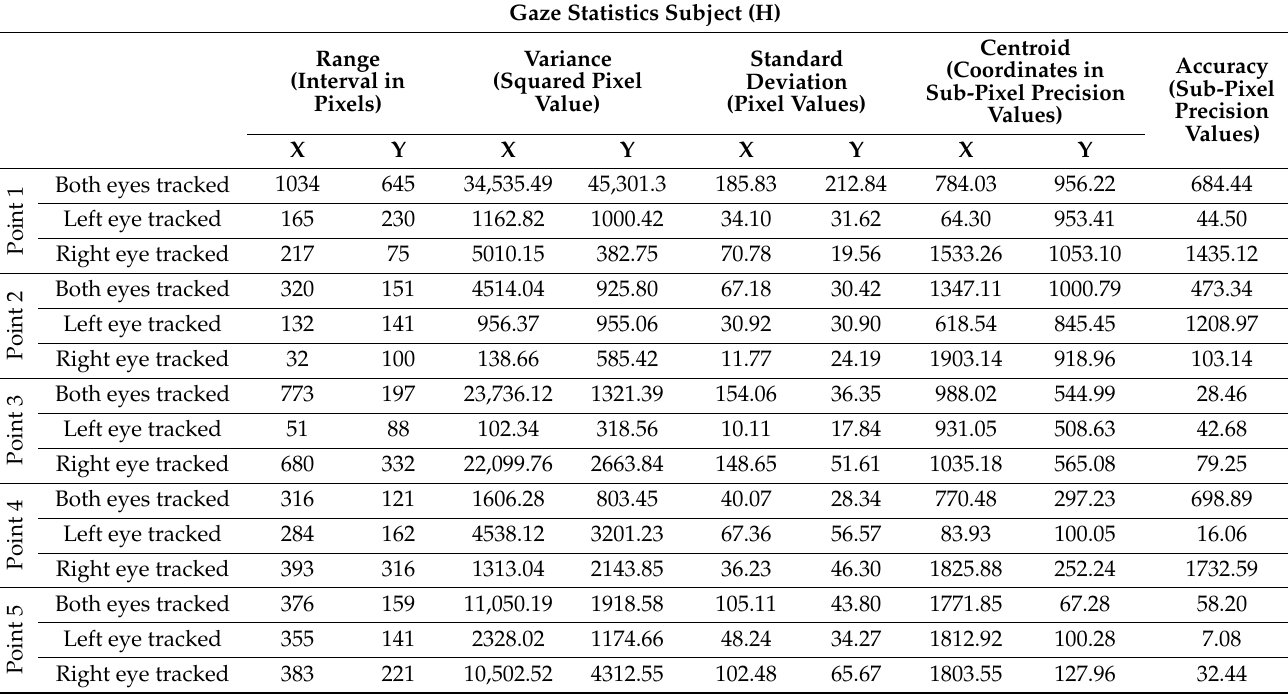
Table 2. Example of a gaze statistic records for a subject H.